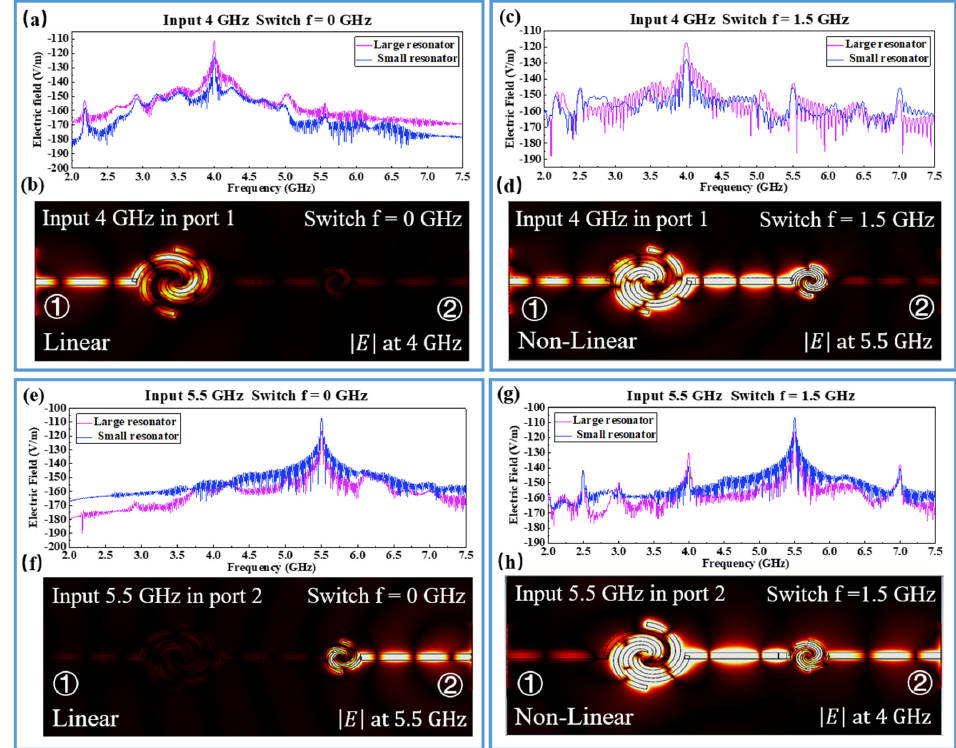
Figure 5. Spiral SPP resonator in the dynamic case: ( a ) Spectrum in the first case: f_input = 4 GHz,